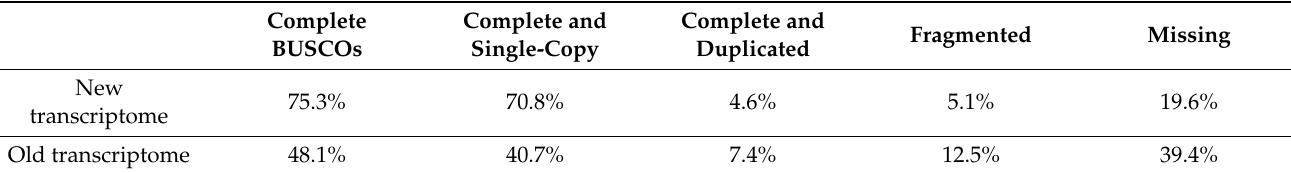
Table 3. The Benchmarking Universal Single-Copy Orthologs (BUSCO) scores from the new and old version of the O. oenanthe